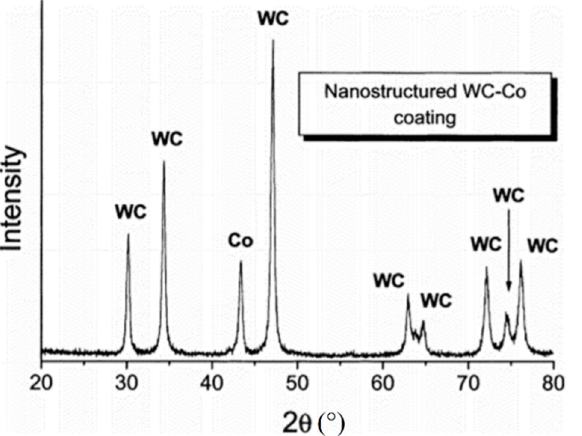
Figure 8. X-ray diffraction (XRD) of the nanostructed WC-12Co coating sprayed by cold spray [131]. Reprinted with permission from [131]. © 2002 Elsevier.